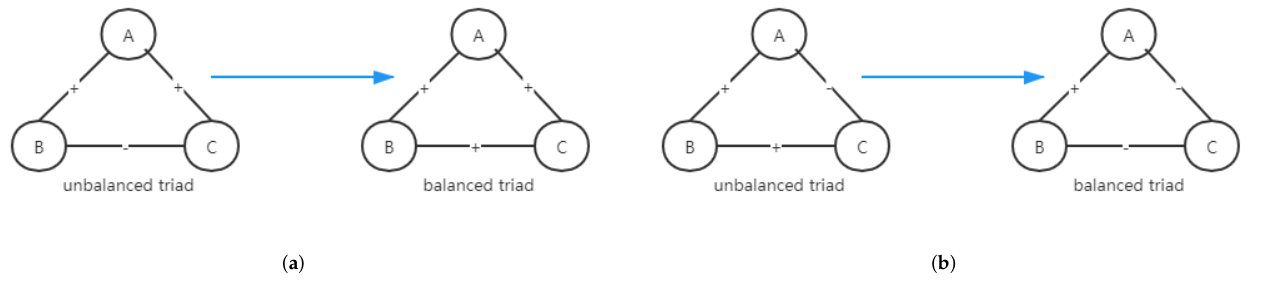
Figure 15. Changes of positive edge: ( a ) the edge between nodes B and C evolves from − 1 to + 1; ( b ) the edge between nodes B and C evolves from + 1 to −